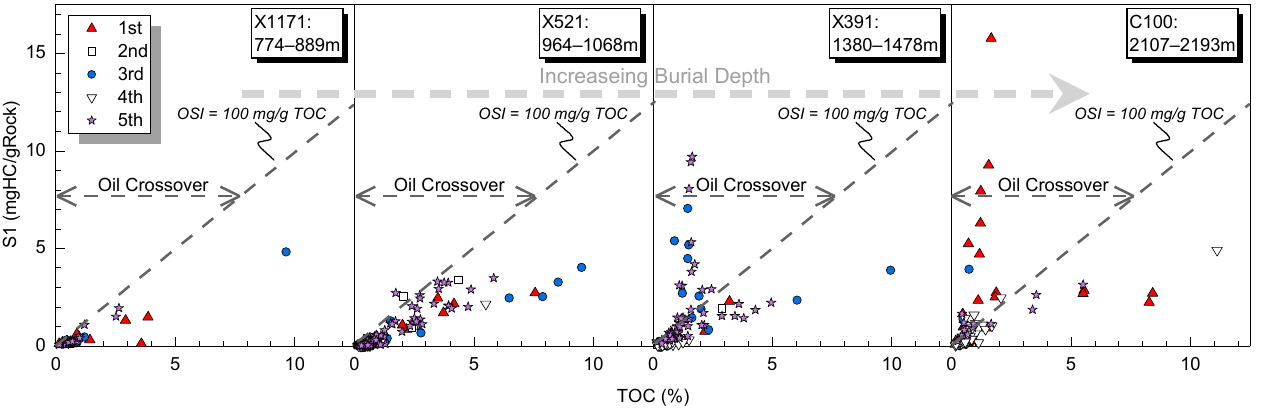
Figure 13. Control of thermal maturity on oil content is revealed by plotting the S1 vs. TOC of wells with different burial depths.